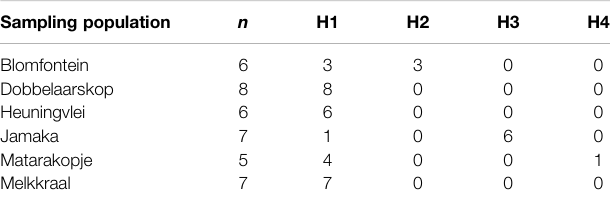
TABLE 5 | Haplotype distribution of collected wild rooibos populations. n — number of individuals per population; H1 — haplotype 1; H2 — haplotype 2; H3 — haplotype 3; H4 — haplotype 4.